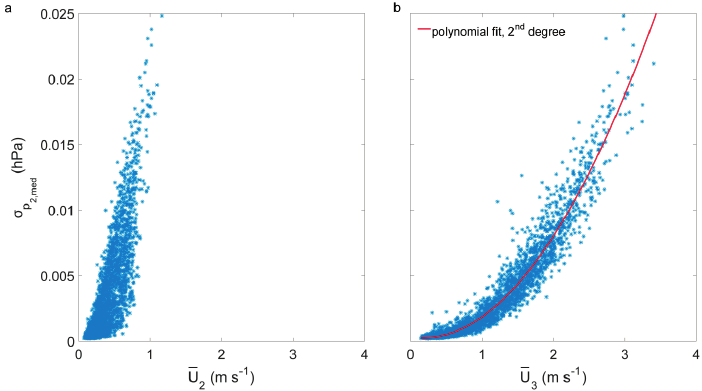
Figure 5. Dependences of the standard deviation of the air pressure signal (cid:1868) (cid:2870) in medium-frequency ) ( a ) on the mean below-canopy wind speed ( (cid:1847)(cid:3365) (cid:2870) ); and ( b ) on the mean above-canopy range ( (cid:2026) (cid:3043) (cid:3118),(cid:3171)(cid:3163)(cid:3162) wind speed ( (cid:1847)(cid:3365) (cid:2871) ).